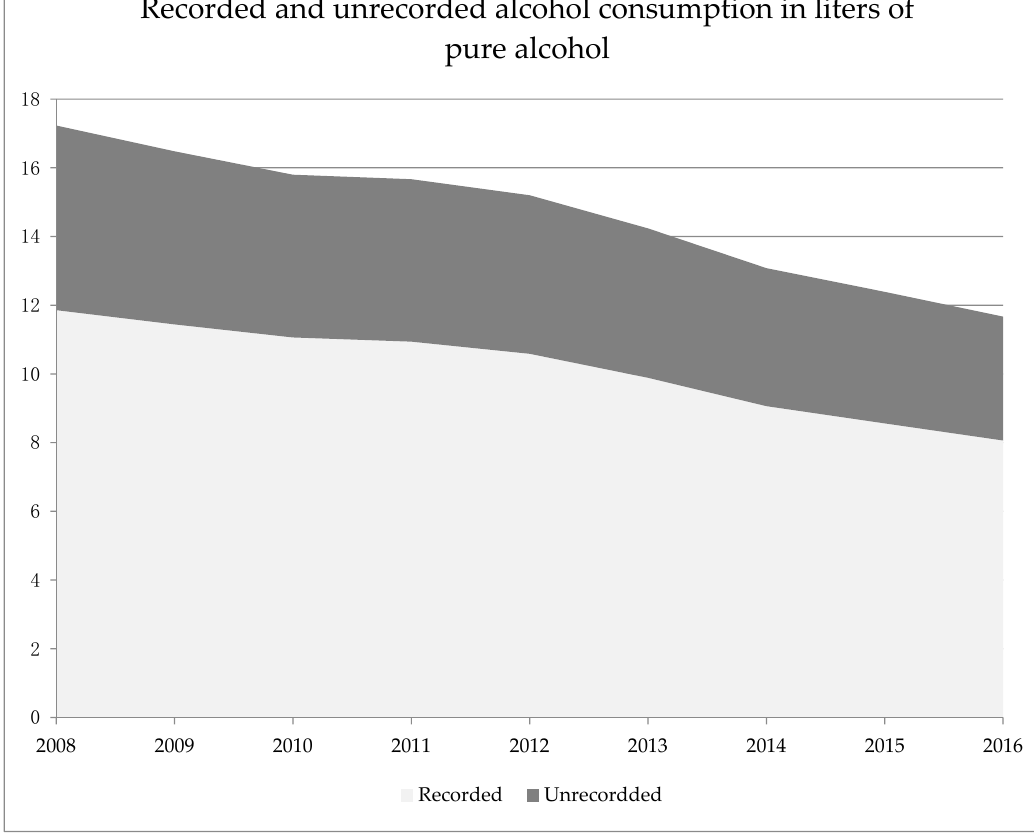
Figure 5. Shares of recorded and unrecorded alcohol consumption among total consumption (15+). Adapted from: World Health Organization Regional Office for Europe, 2019 [11], and Manthey et al., 2019 [77].